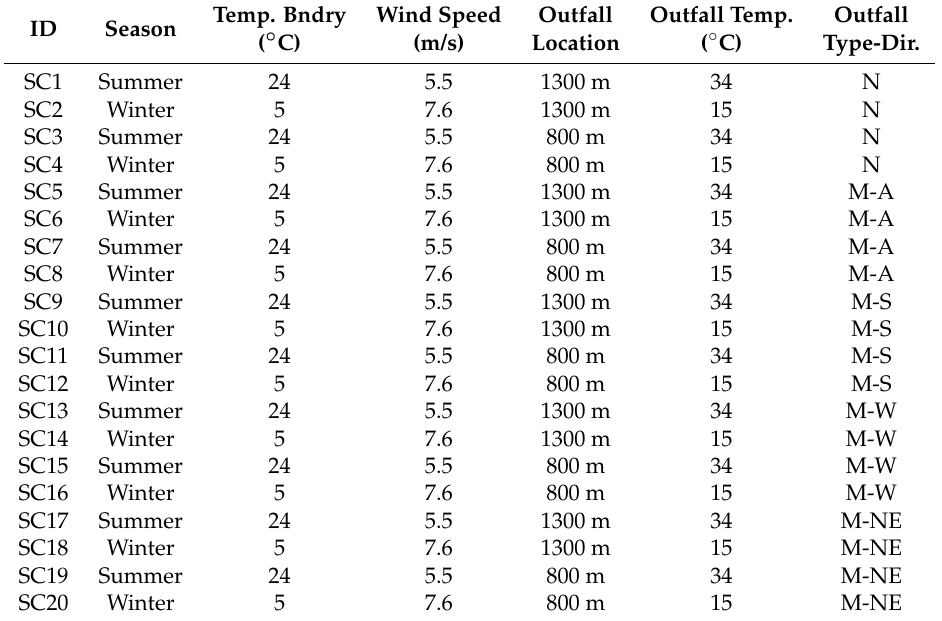
Table 4. Special settings of model scenarios. N stands for Normal; M-A for Momentum Alternating north and south ports; M-S, M-W and M-NE for Momentum with ports pointing towards the South, West and Northeast,